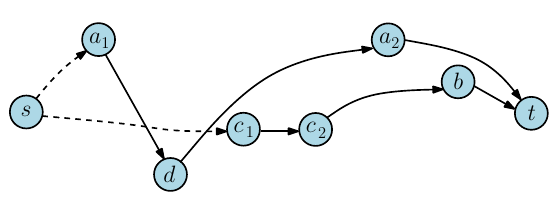
Figure 4 An optimal solution to the example from Fig.